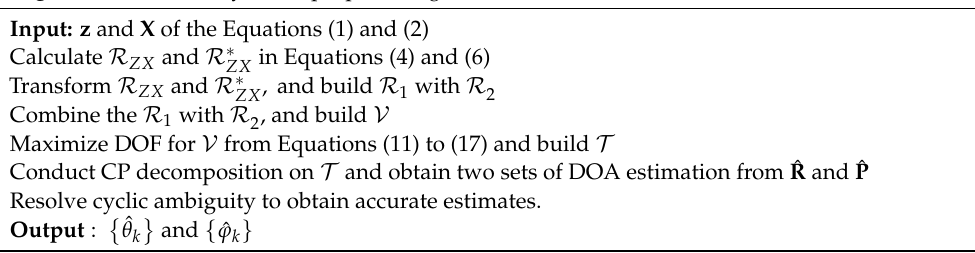
Algorithm 1. Summary of the proposed